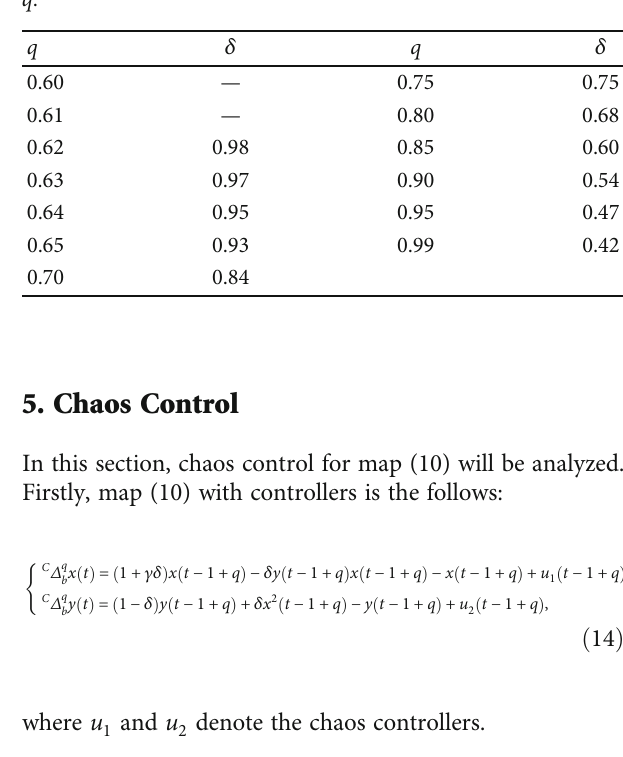
Figure 4: Bifurcation diagrams of map (10) when γ and q are varied. (a) q ∈ ½ 0 : 7, 0 : 99 (cid:2) . (b) q ∈ ½ 0 : 7, 0 : 75 (cid:2) . Table 1: Hopf bifurcation points of map (10) for di ff erent values of q